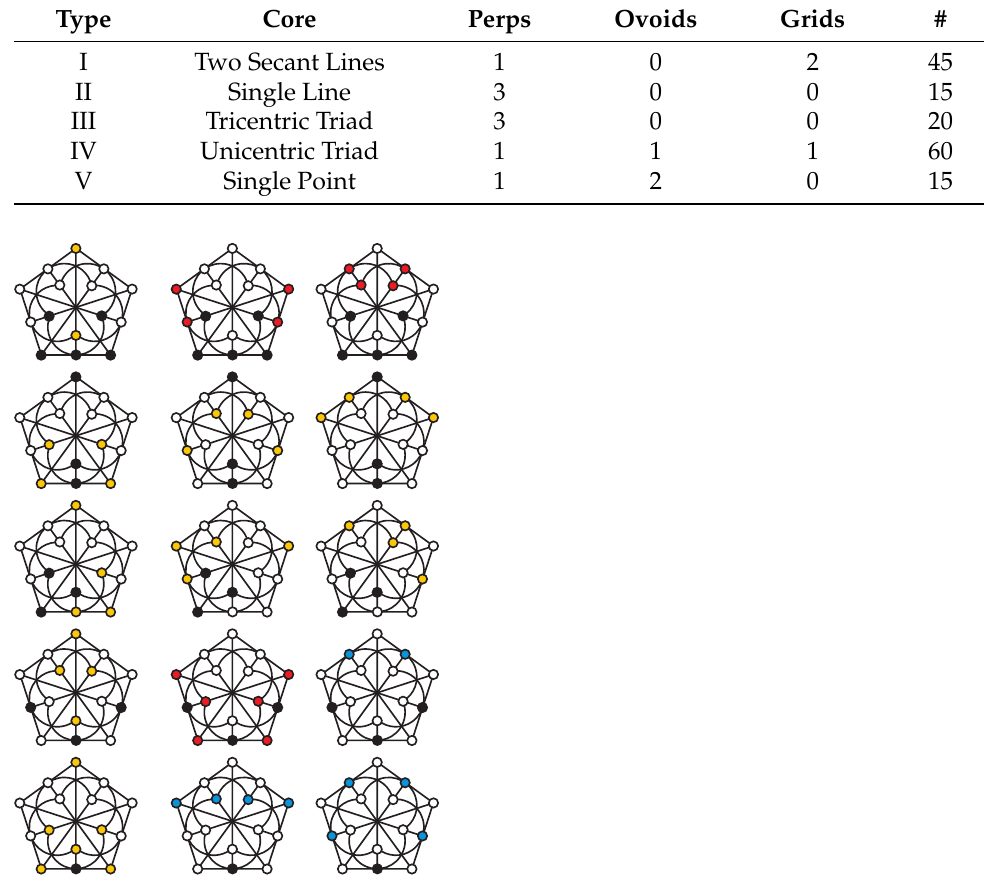
Figure 2. An illustrative portrayal of representatives (rows) of the five (numbered consecutively from top to bottom) different types of lines of V ( W ( 3,2 )) , each being uniquely determined by the properties of its core (black